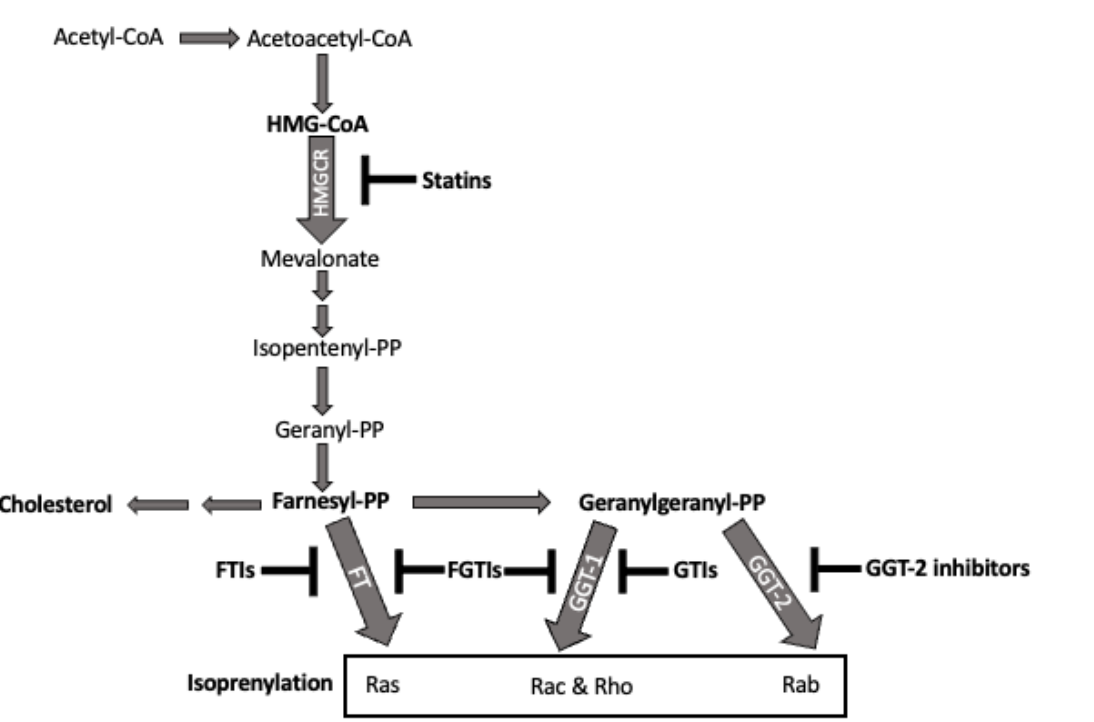
Figure 1. Cholesterol synthesis and relevant inhibitors. Figure depicts an abbreviated version of cholesterol synthesis with isoprenyl lipids in bold font. Statins act at the rate limiting step of mevalonate synthesis. Ras family proteins are substrates for the indicated isoprenyl transferases, which can be targeted by multiple drugs. FTIs = farnesyl transferase inhibitors; FGTIs = dual inhibitors of farnesyl transferase and geranylgeranyl transferase-1 (GGT-1); GTIs = GGT-1 inhibitors.